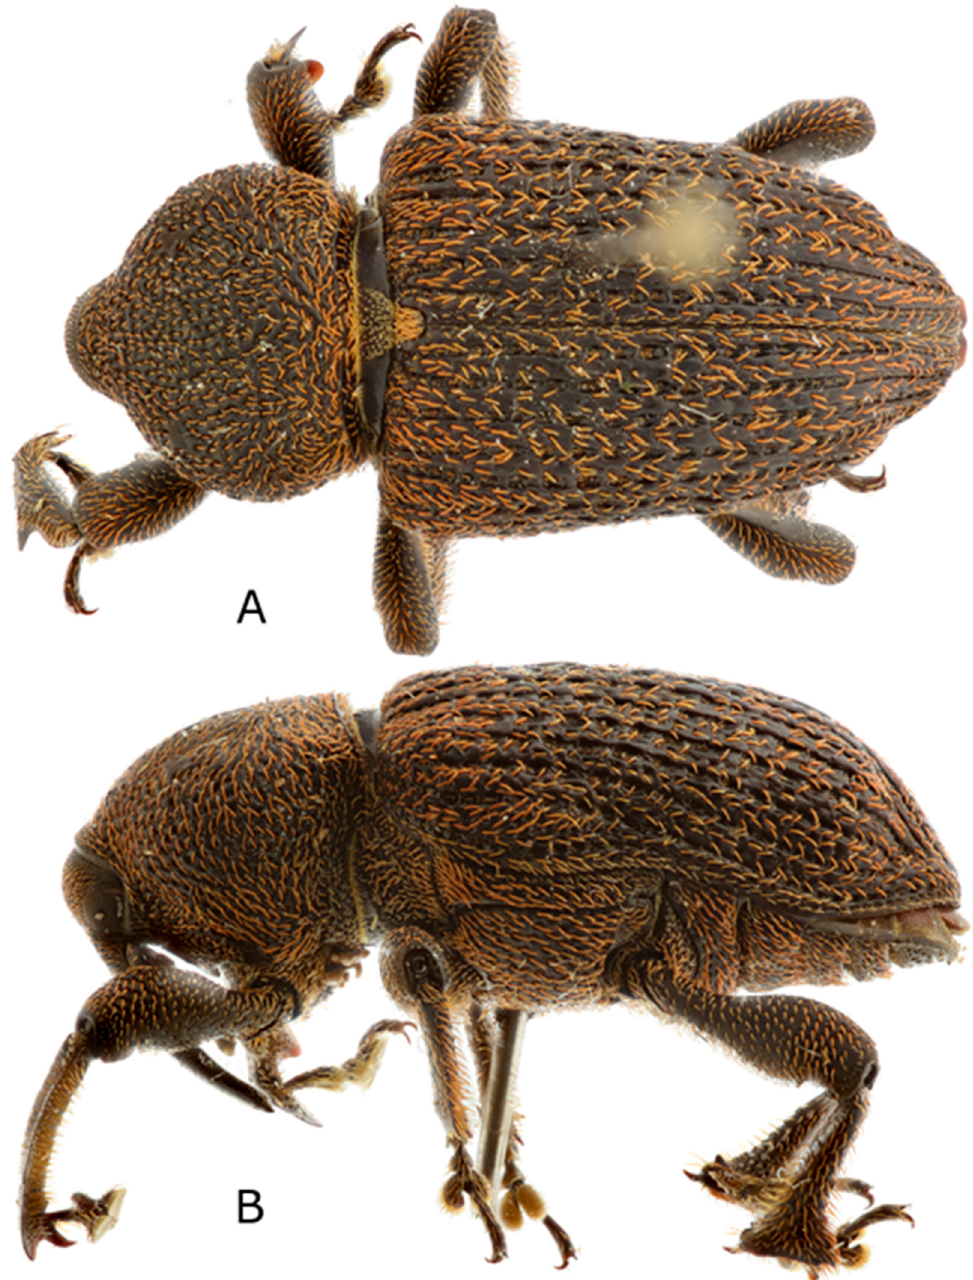
Figure 19. Sclerocardius indicus Hartmann habitus, ( A ) dorsal, and ( B ) lateral. Head. Rostrum weakly curved, similar in males and females; strongly punctate laterally in basal half above scrobe and distally at same level as scrobe, weakly to strongly punctate dorsally basal to antennal insertion, very weakly punctate more distally, sometimes with rounded longitudinal ridges dorsally basally, each puncture with orange elongate setiform scale, longer than diameter of puncture; abruptly narrowed before eyes lateroventrally to form a notch. Head capsule strongly punctate dorsally, each puncture with an orange elongate setiform scale, longer than diameter of puncture. Thorax . Pronotum with length:width 0.91–1.0 (mean 0.94, n = 10), as high as long when